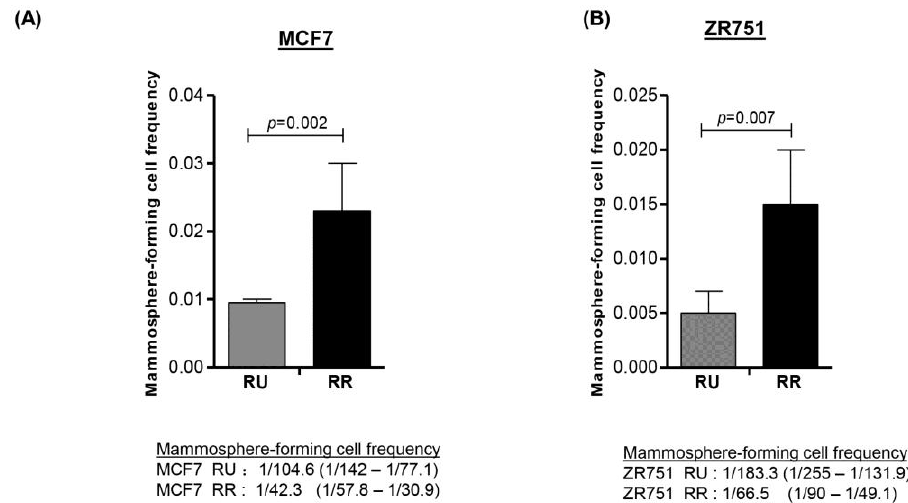
Figure 1. Reporter responsive (RR) cells were significantly more capable in forming mammospheres in the setting of limiting dilutions. Reporter unresponsive (RU) and RR cells derived from MCF7 and ZR751 cells were serially diluted and seeded into low attachment 96-well plates. After 7 days, the spheres were counted and data was analyzed using ELDA software. ( A ) RR cell subset purified from MCF7 cells had a median frequency of 1/42.3 mammosphere forming cells, as compared to 1/104.6 in the RU subset ( p = 0.002); ( B ) RR cell subset purified from ZR751 cells had a median frequency of 1/66.5 mammosphere forming cells, as compared to 1/183.3 mammosphere forming cells in the RU subset ( p = 0.007).